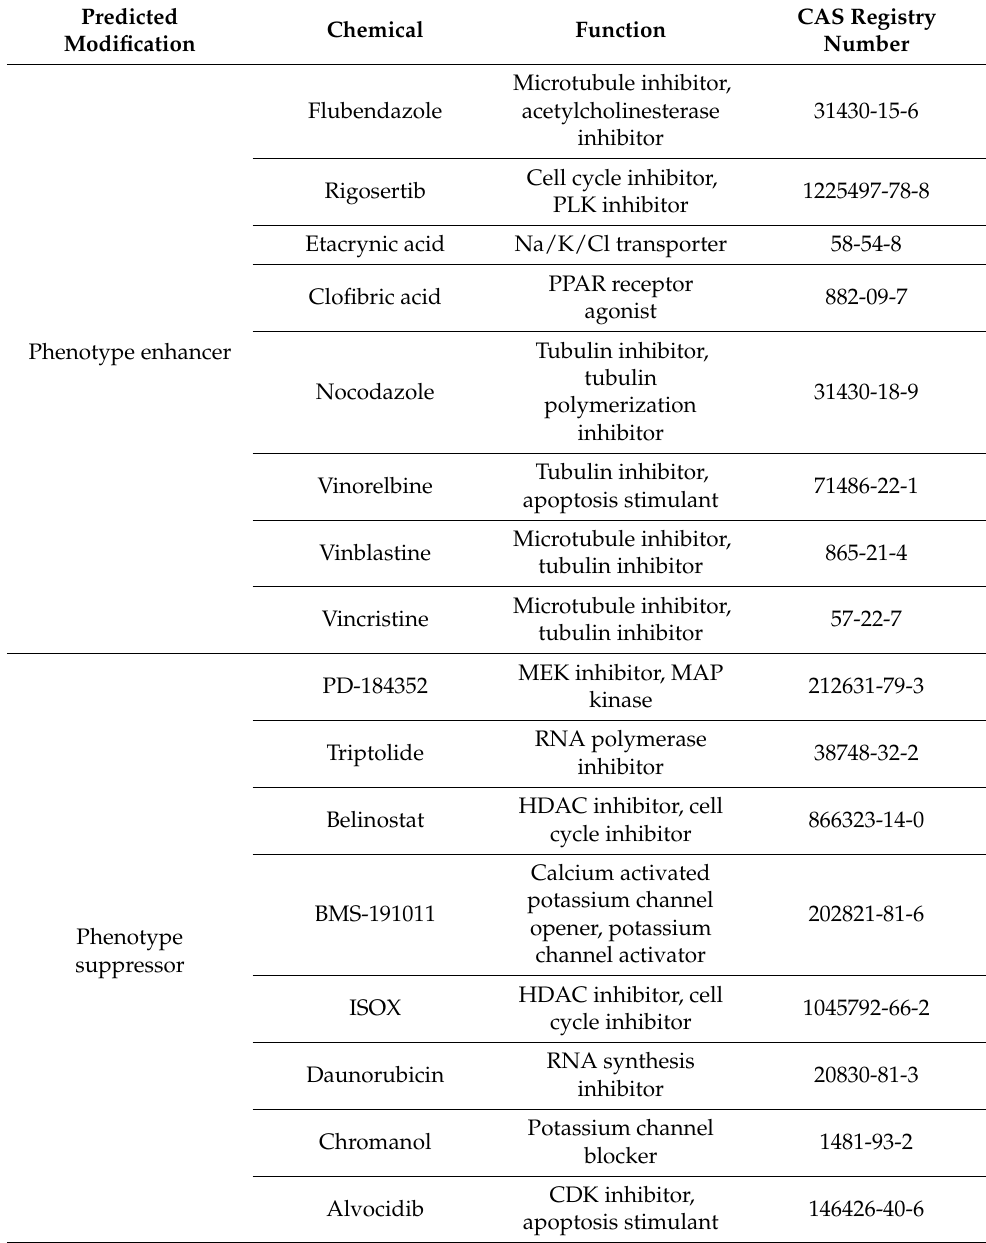
Table 1. Predicted chemical modifiers identified by L1000